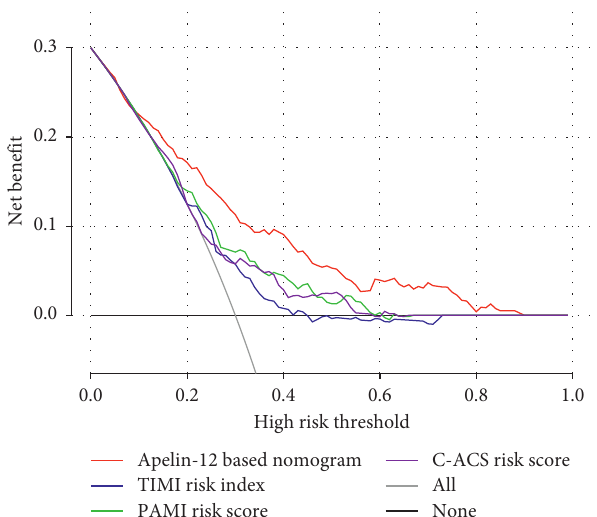
Figure 5: Decision curve analysis of apelin-12 based nomogram and other already available risk scores in terms of major adverse cardiovascular events risk in the whole cohort. The X -axis repre- sents the threshold probability. The Y -axis measures the net benefit. The red line illustrates the major adverse cardiovascular events risk nomogram. The threshold probability is where the expected benefit of treatment balances the expected benefit of avoiding treatment.